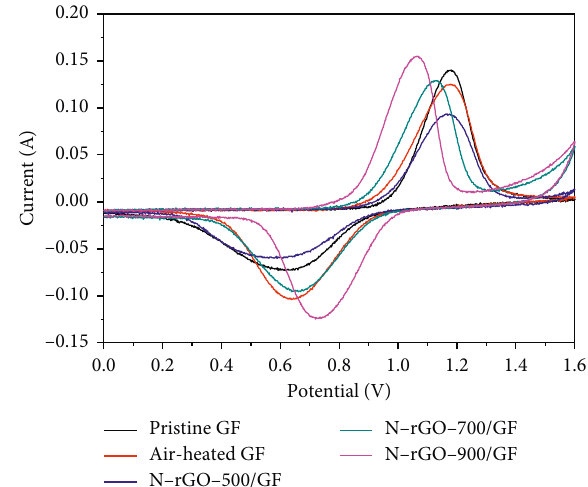
Table 2: Surface species content of N-rGO-modified GF samples by XPS results.